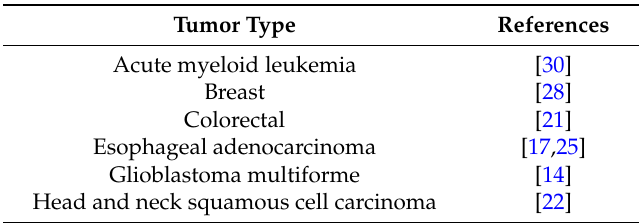
AXL expression in human cancers correlates with poor prognosis, metastasis, and drug